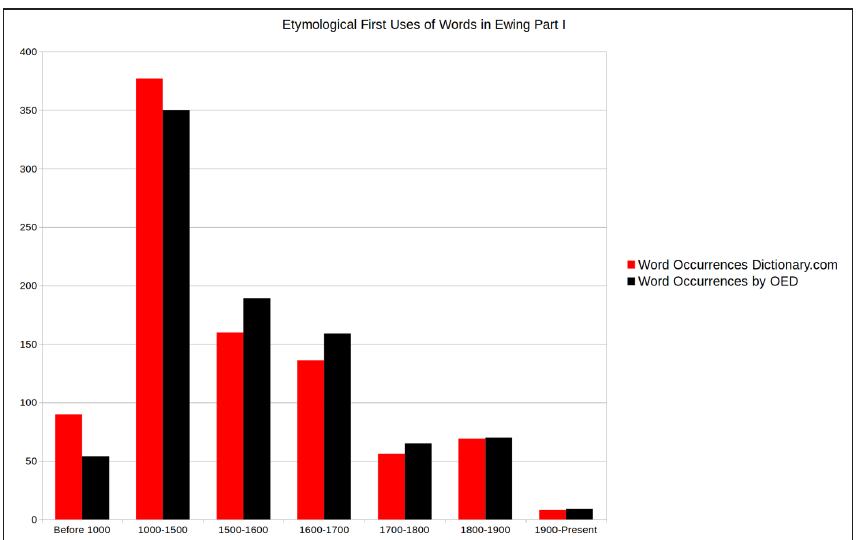
Figure 1: Word distributions by first-usage according to Dictionary.com and the